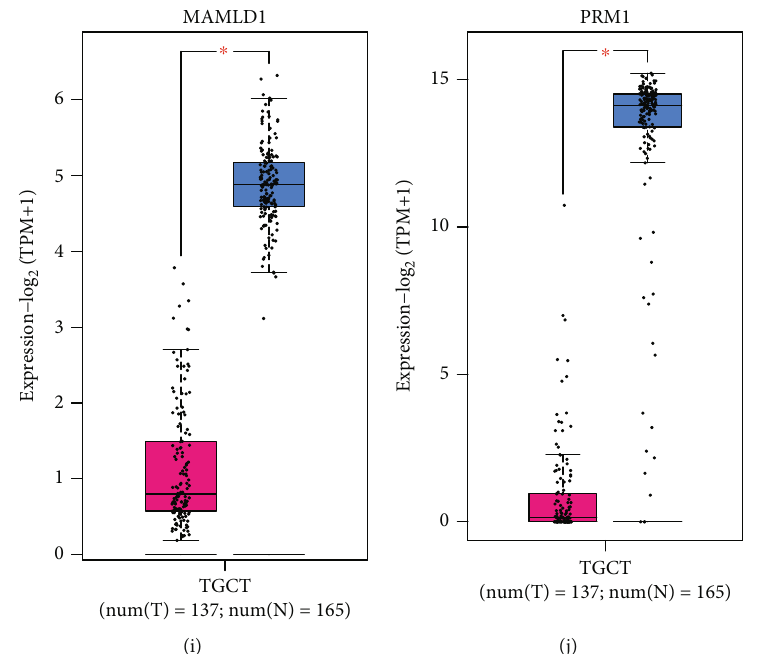
Figure 3: Cancer-related risk genes in TGCT. (A) Venn diagram of DEGs and survival-related genes in TGCT. (b – j) Gene expression in cancerous and normal samples. Red represents TGCT samples, and blue represents normal samples. ∗ P < 0 : 05